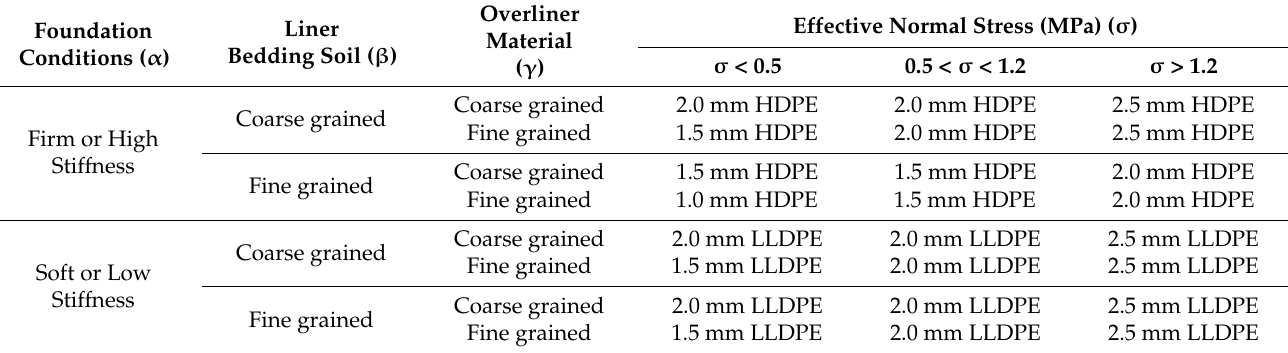
Table 4. Geomembrane liner design matrix